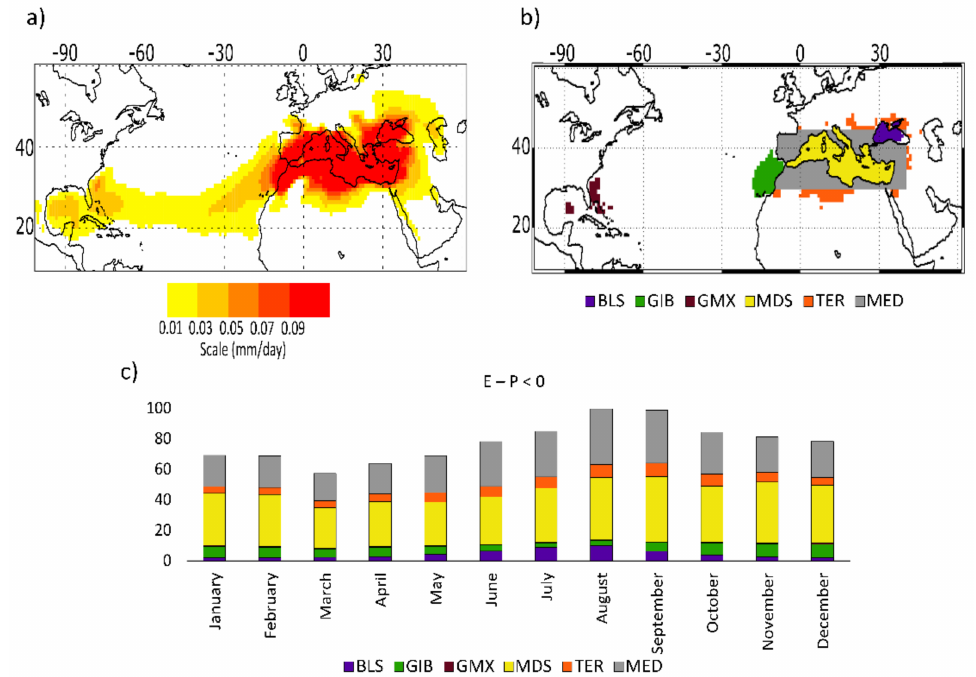
Figure 3. ( a ) Climatological annual (E − P > 0) values integrated backward in time over 10 days for the Mediterranean region (MED) (mm/day); ( b ) Schematic representation of the main moisture sources